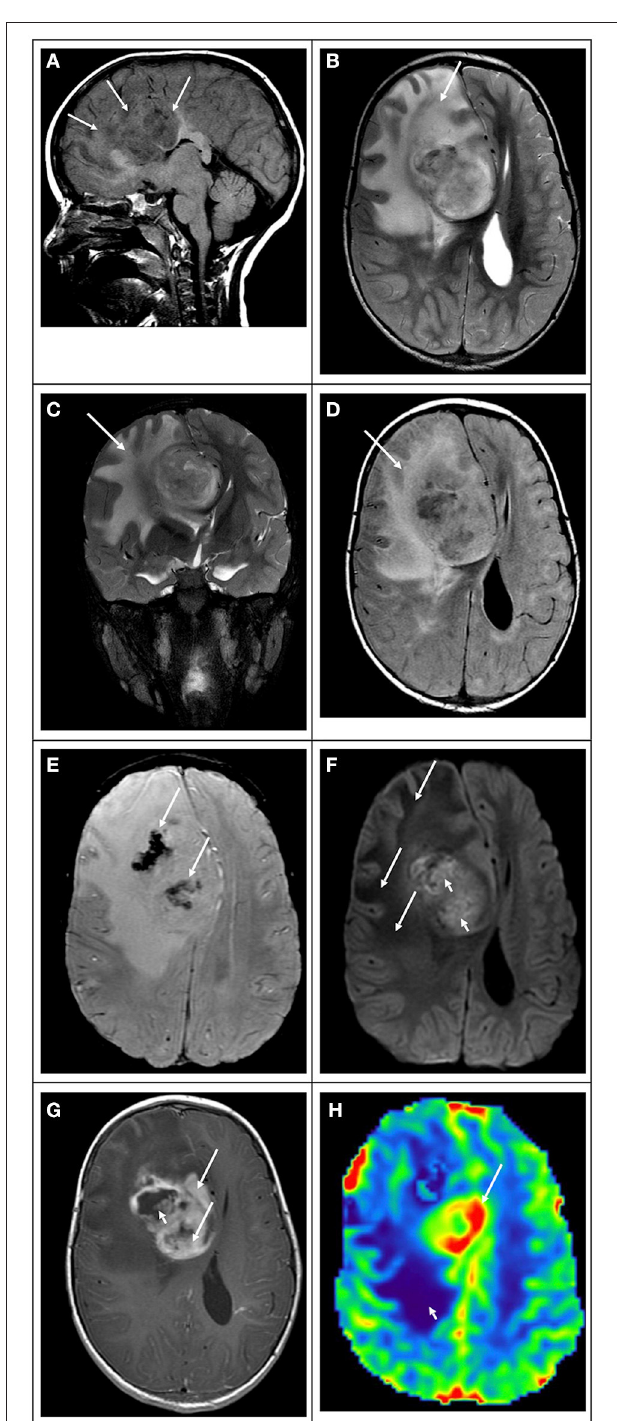
FIGURE 10 | 5-year-old male with headaches and confusion due to a right frontal “glioblastoma.” (A) T1 weighted image in the sagittal plane shows that the lesion is heterogeneous, ill-defined with mixed-signal, predominantly hypointense, and infiltrates the corpus callosum (white arrows). (B) T2 weighted image in the axial plane, (C) T2 weighted image in the coronal plane, and (D) FLAIR image in the axial plane show that the bulk of the lesion